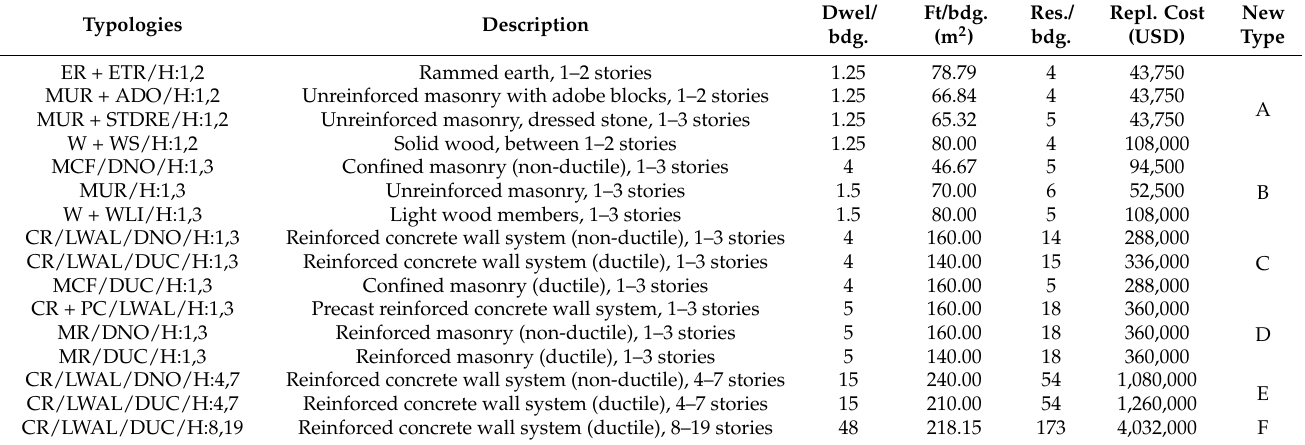
Table 1. SARA building classes proposed for the study area along with short descriptions. Average number of dwellings (Dwel./bdg), nighttime residents (Res./bdg), and replacement cost (Repl. Cost (USD)) are reported as in [67] and in https://sara.openquake.org/ (accessed date: 21 December 2021). Average footprint area (Ft./bdg. m 2 ) values are derived from the construction quality categories per dwelling as suggested in [67] as well as the mean range of storeys and dwellings per class (see Table A1). A new typology in the range A–F is proposed in terms of the similarities of their footprint areas.